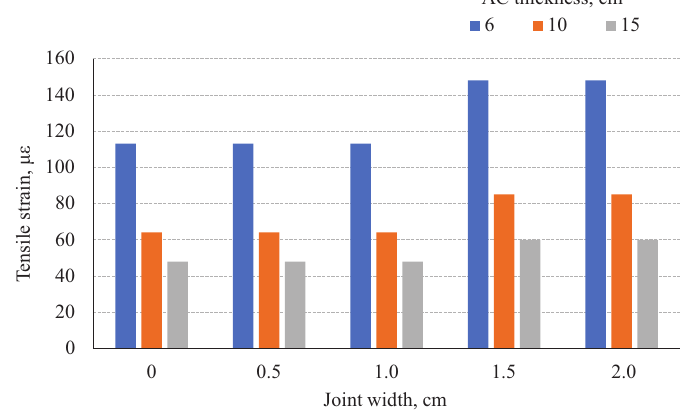
Figure 11. Longitudinal tensile strain at the bottom of the asphalt concrete versus joint